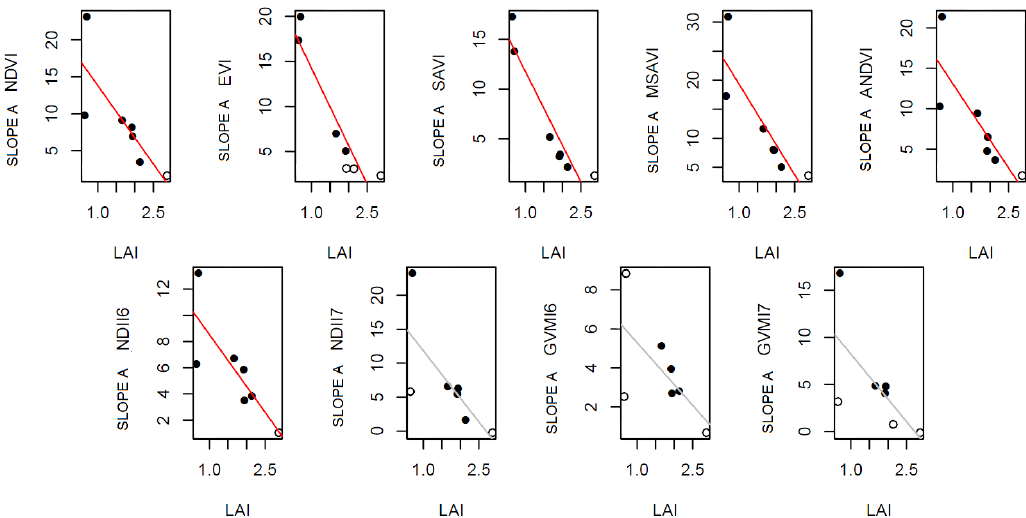
Figure 4. Relationship between LAI plot (X-axis) level and Slope(A) of (EWT CAN , VI) (Y-axis). (Red line, significant relationship p -value < 0.05; grey line, no significant relationship). Black dots represent significant plot-level relationships, and empty dots represent non-significant relationships at the 0.05 threshold for p